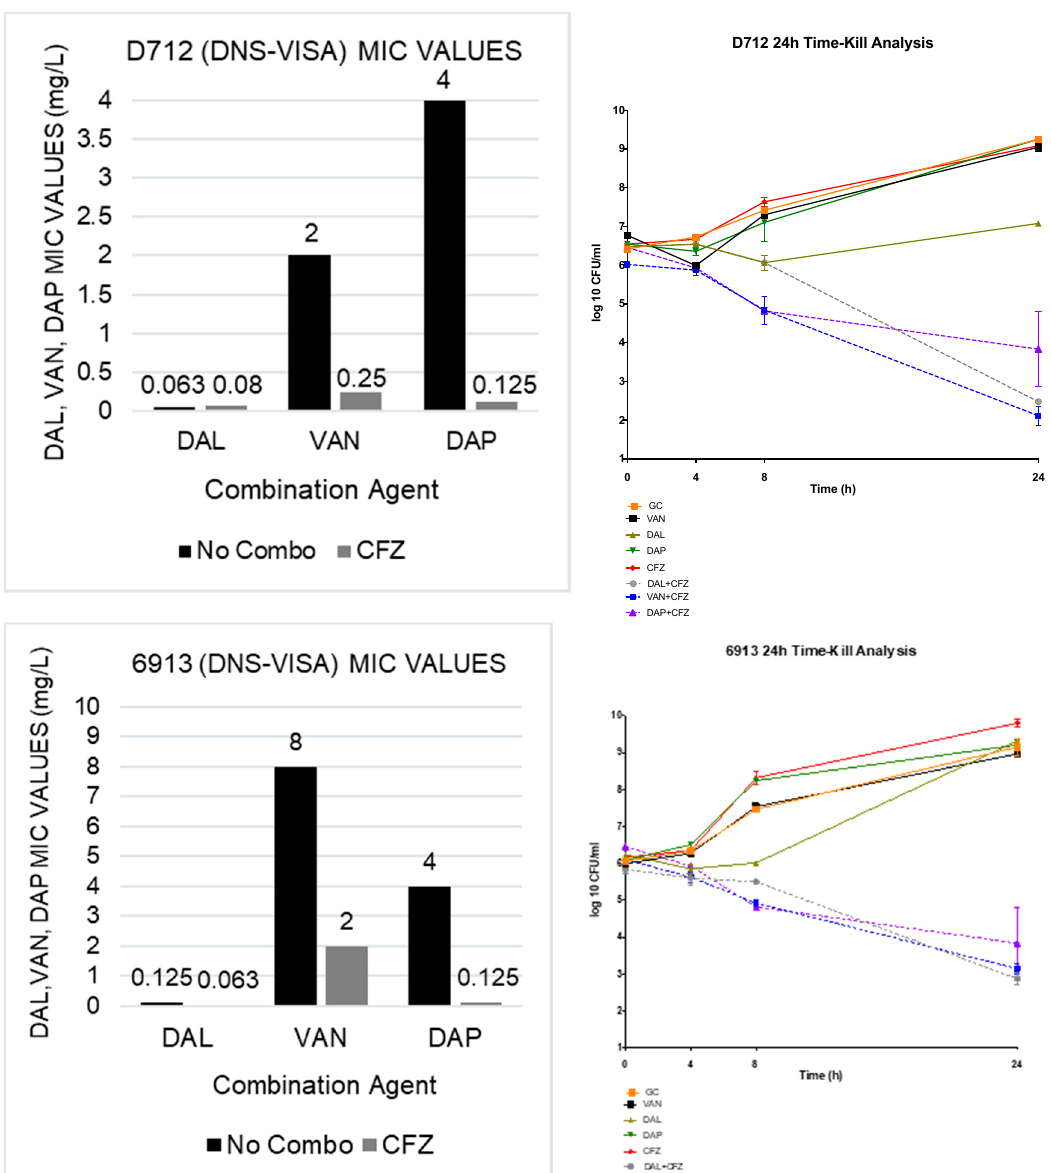
Figure 1. TKA evaluating DAL, VAN and DAP alone and in combination with CFZ on 2 DNS (684 and 8846) and 2 DNS-VISA strains (D712 and 6913).